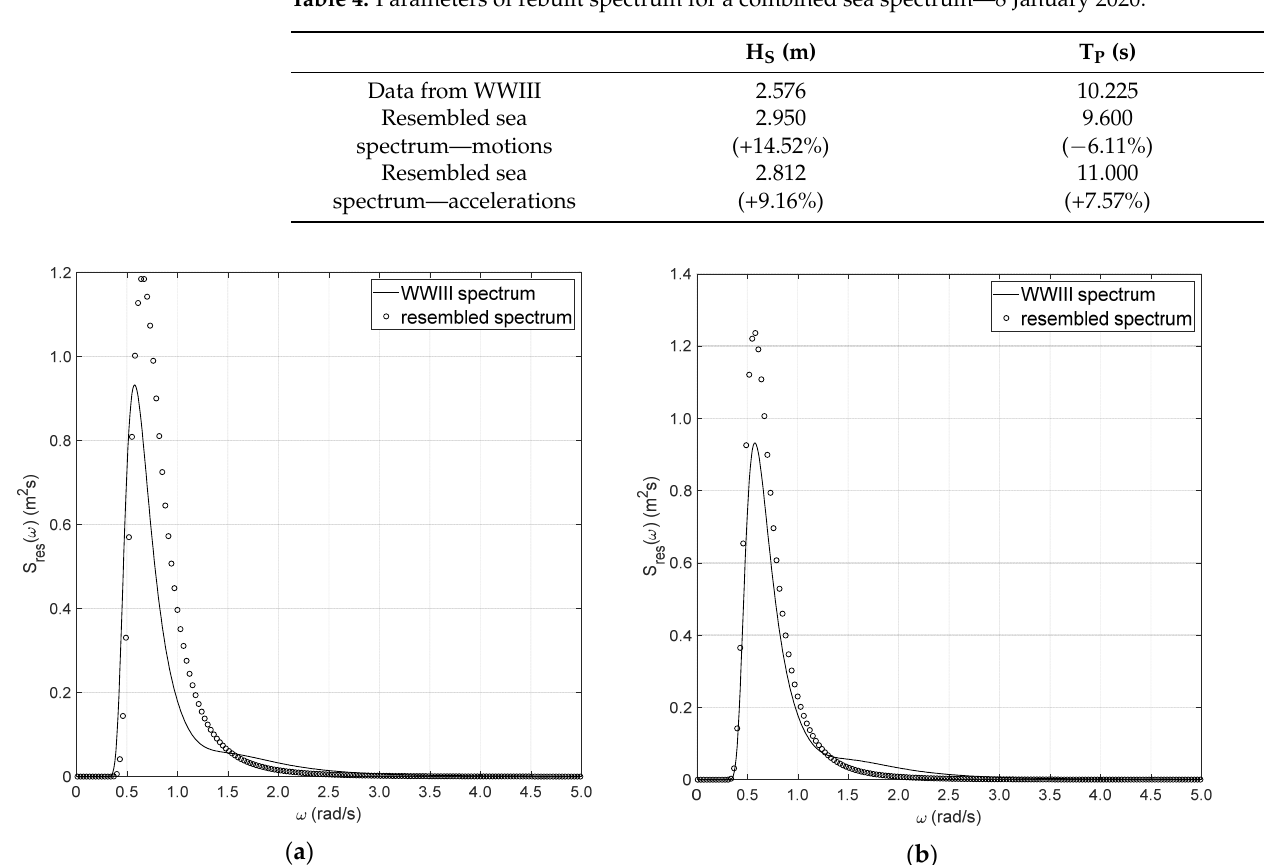
Figure 7. Sea spectrum—8 January 2020: ( a ) resembled combined sea spectrum using heave and pitch motions; ( b ) resembled combined sea spectrum using heave and pitch accelerations.